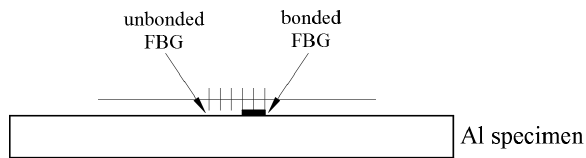
Figure 1. A schematic diagram of bonded and unbonded fiber Bragg grating (FBG) on the Al specimen.